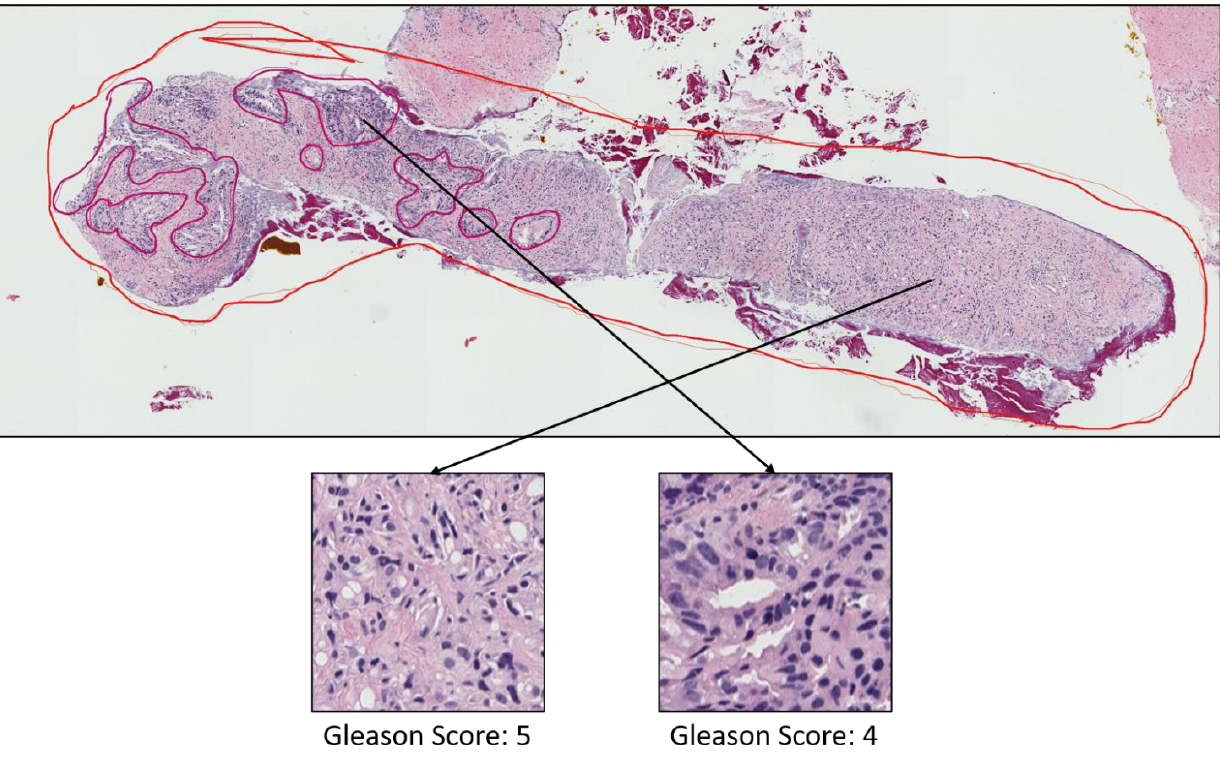
Figure A1. Prostate adenocarcinoma with Gleason scores 4 and 3 annotated with red and blue color, respectively.